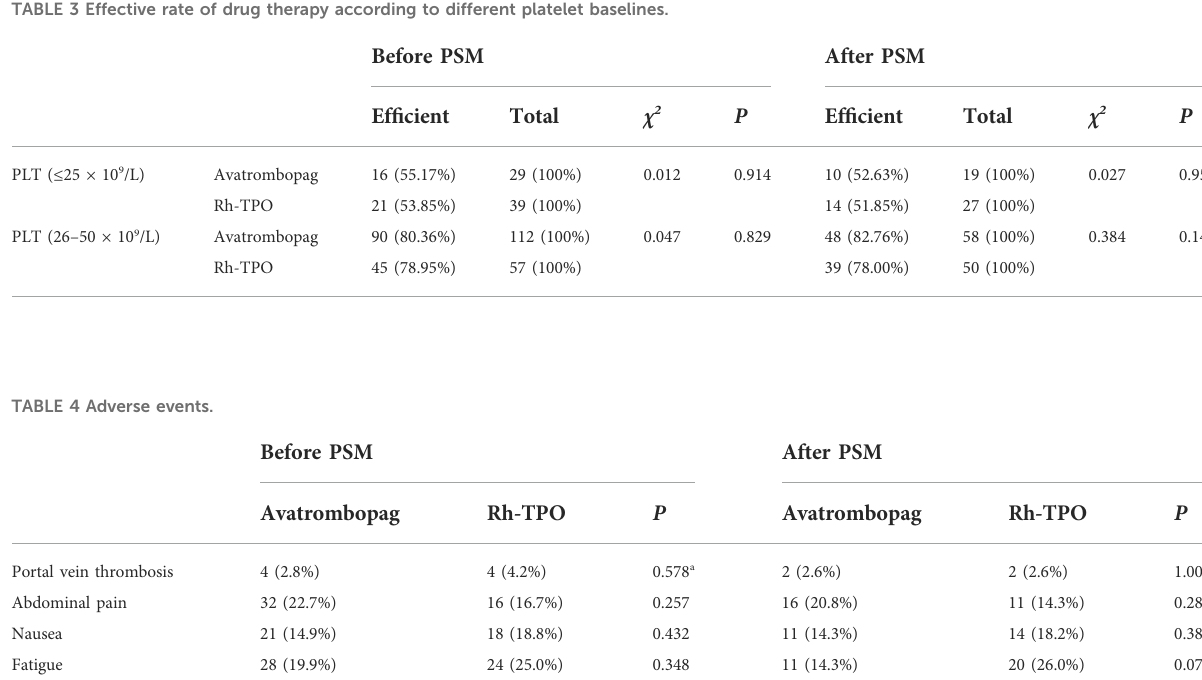
TABLE 3 Effective rate of drug therapy according to different platelet baselines.